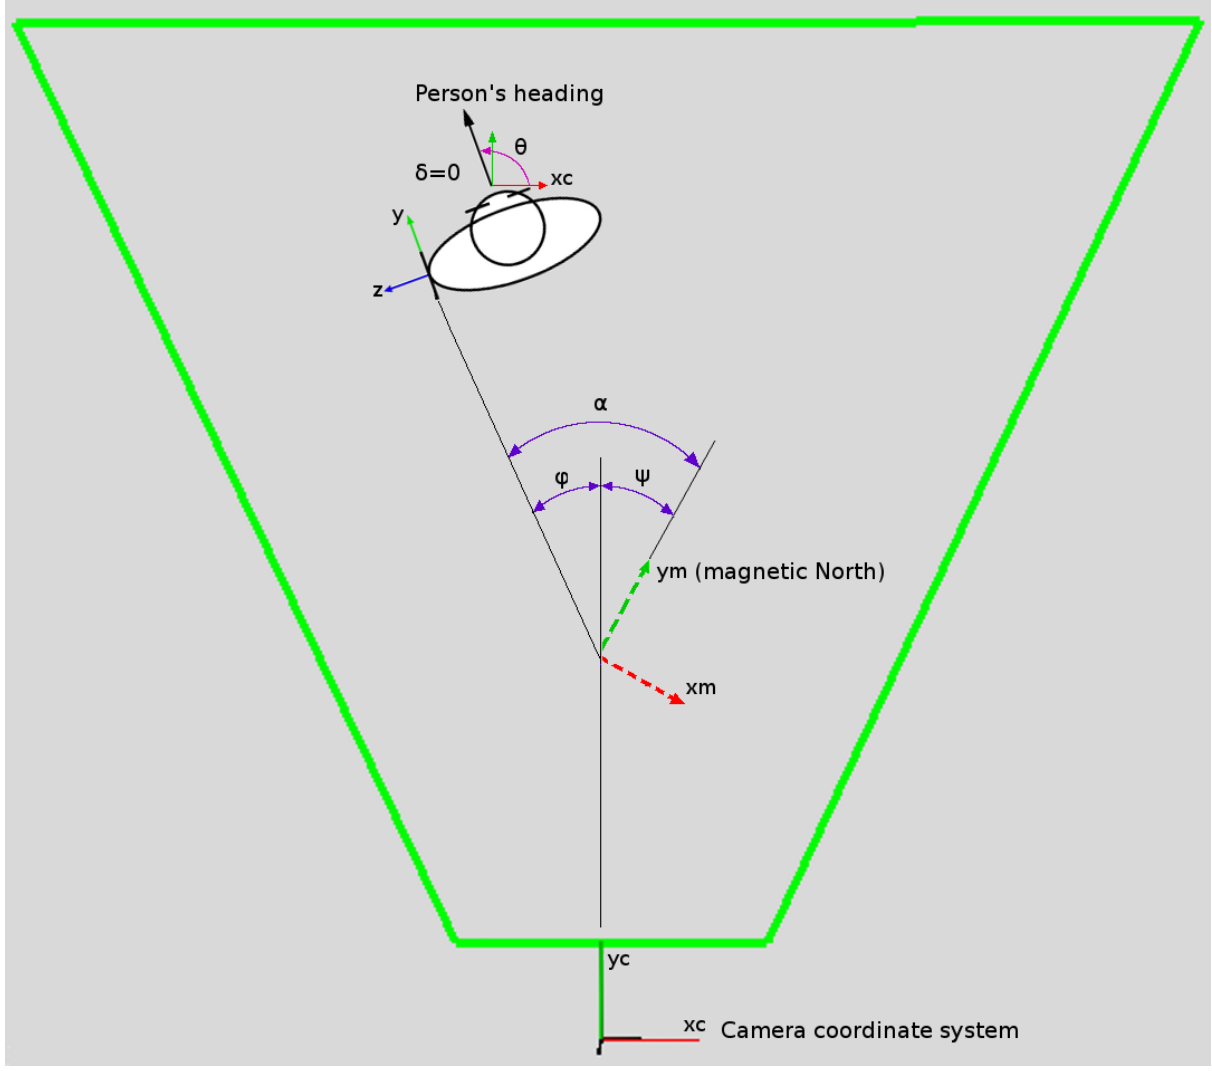
Figure 5. Overhead view of the relations between the different frames in the system.